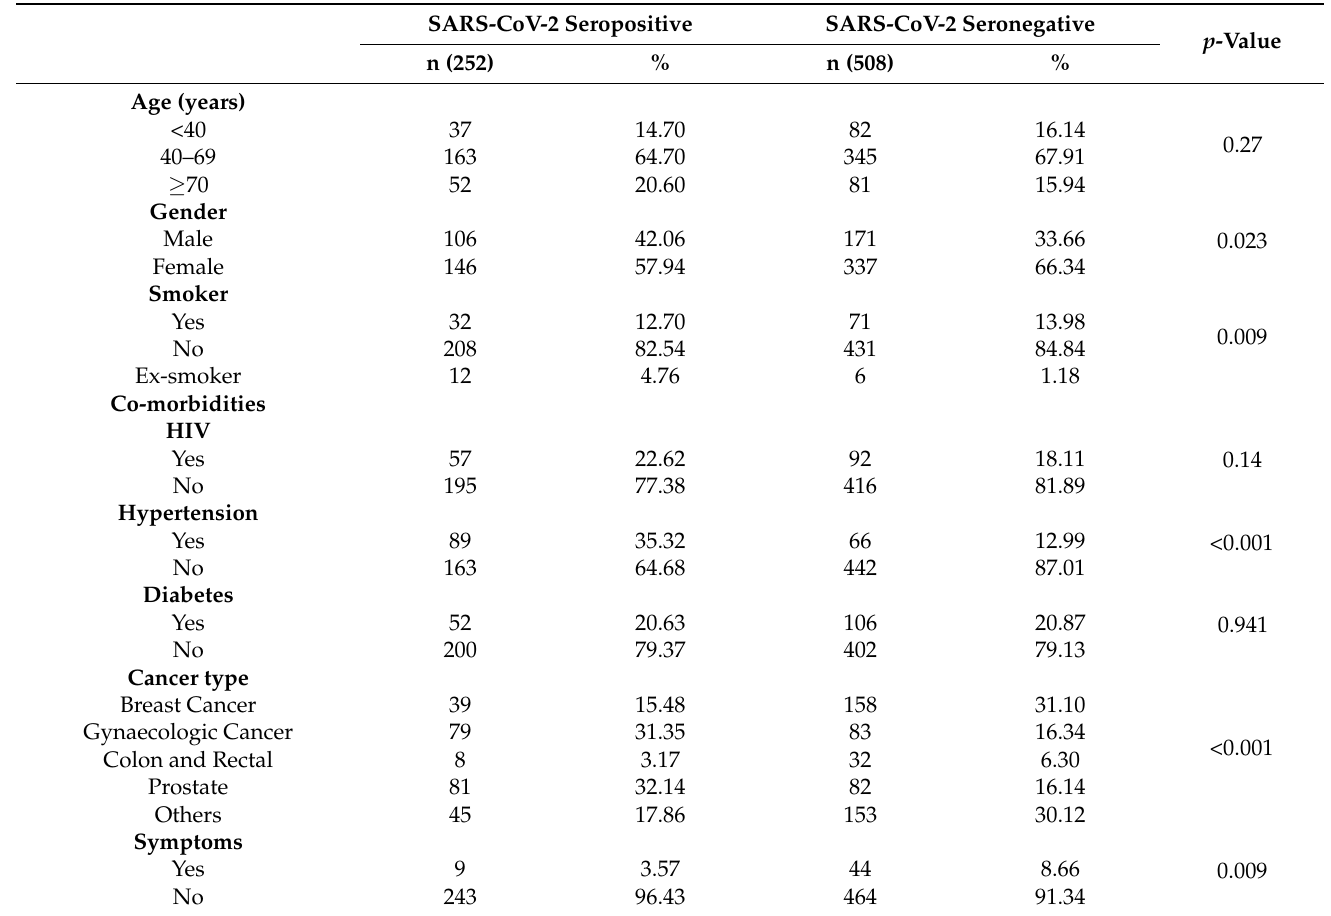
Table 2. General characteristics of patients, tumour type, underlying co-morbidities, and SARS-CoV-2 seroprevalence. SARS-CoV-2